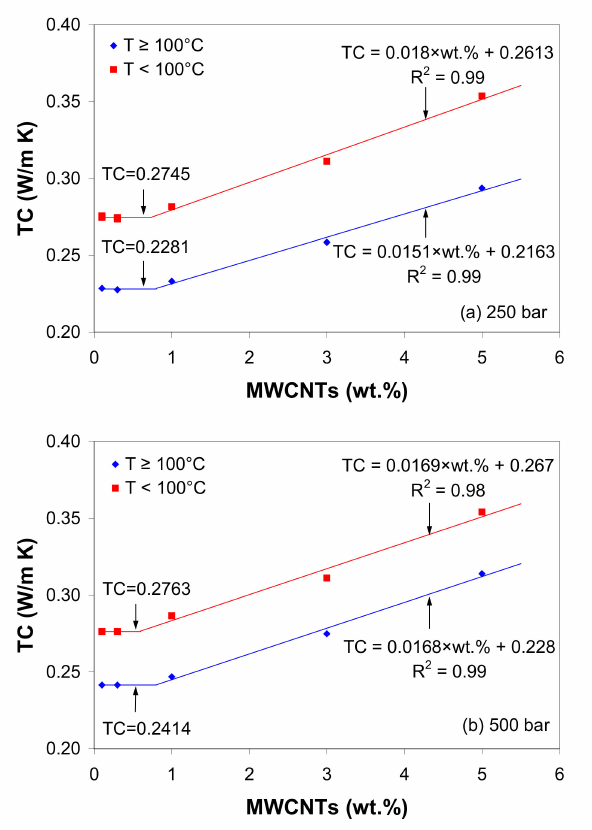
Figure 14. E ff ect of MWCNT loading on thermal conductivity of the LDPE / MWCNT composite at ( a ) 250 bar and ( b ) 500 bar. The solid lines show data fitting to linear models, whose parameters are given in the